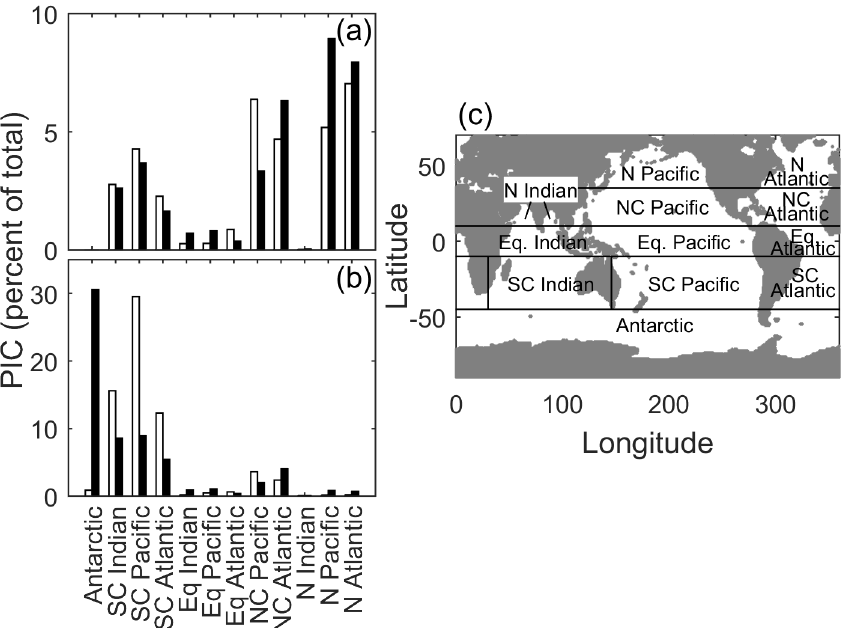
Figure 8. Satellite-derived particulate inorganic carbon (black bars) and E. huxleyi -based CCPP (white bars) estimates for major ocean biogeographical provinces as percentages of total production in (a) austral winter/boreal summer and (b) austral summer/boreal winter. (c) Major ocean biogeographical province